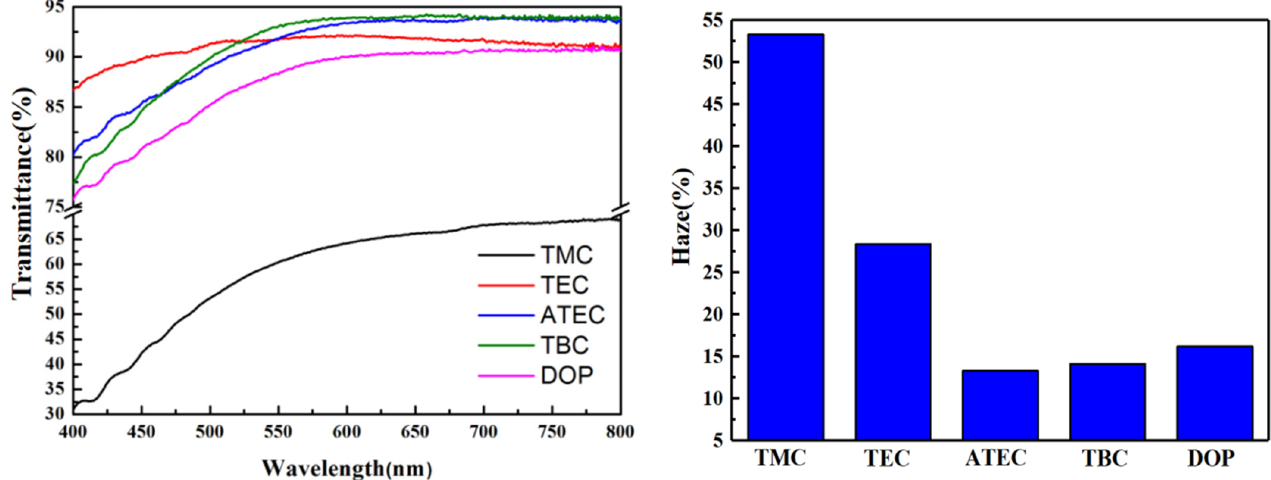
Figure 4. The transmittance and haze of PVC with 2 phr Zn(Arg) 2 plasticized by citric acid esters and DOP.